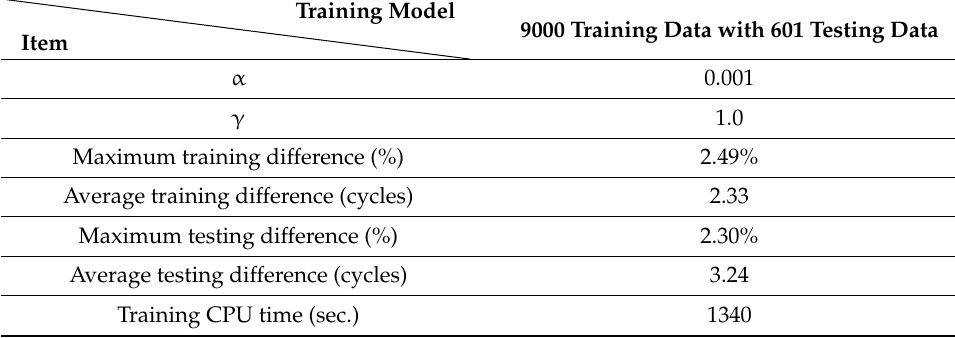
Table 13. The performance of the KRR model with 9000 data.